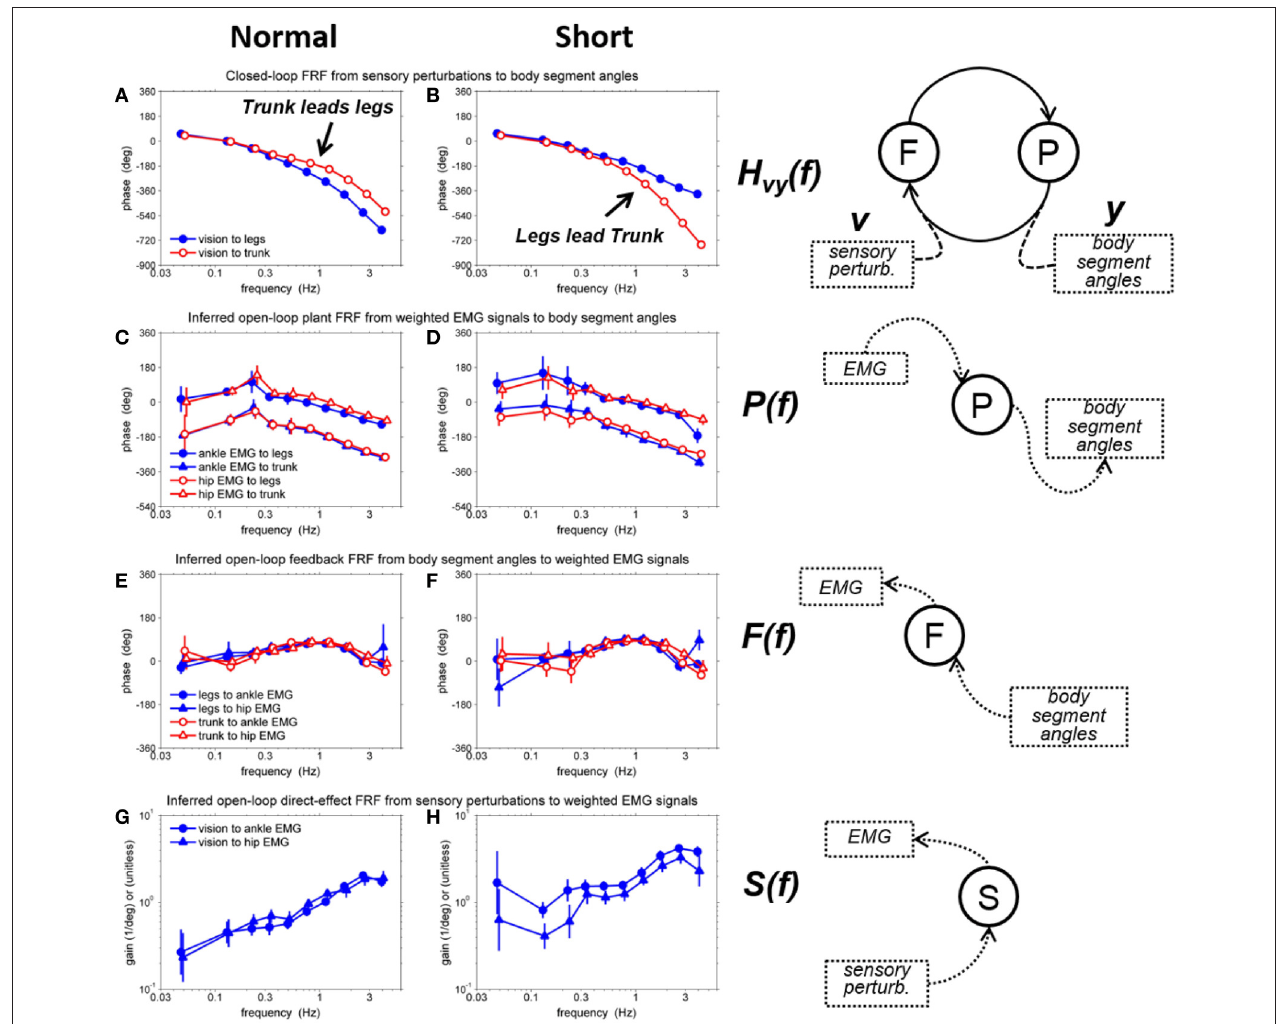
FIGURE 5 | Representative FRFs on a normal and short support surface. (A) phase of closed-loop FRF from visual sensory perturbation to body segment angels on the normal support surface, (B) phase of closed-loop FRF from visual sensory perturbation to body segment angels on the short support surface, (C) phase of inferred open-loop plant FRF from weighted EMG signals to body segment angles on the normal support surface, (D) phase of inferred open-loop plant FRF from weighted EMG signals to body segment angles on the short support surface, (E) phase of inferred open-loop feedback FRF from body segment angles to weighted EMG signals on the normal support surface, (F) phase of inferred open-loop feedback FRF from body segment angles to weighted EMG signals on the short support surface, (G) gain of inferred open-loop direct-FRF from visual sensory perturbations to weighted EMG signals on the normal support surface (H) gain of inferred open-loop direct-FRF from visual sensory perturbations to weighted EMG signals on the short support surface. Error bars denote bootstrap standard